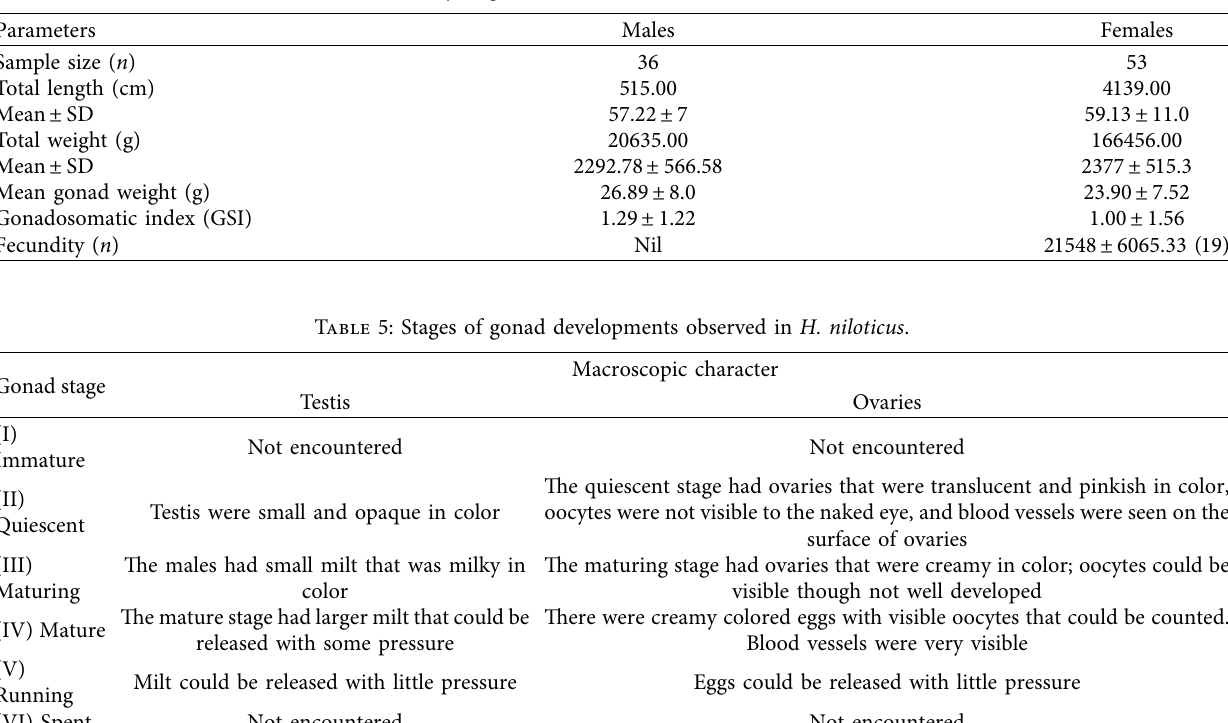
Figure 10: Relationship between prey body weight and total length of Heterotis niloticus . Table 4: Summary of gonadosomatic index (GSI) of Heterotis niloticus